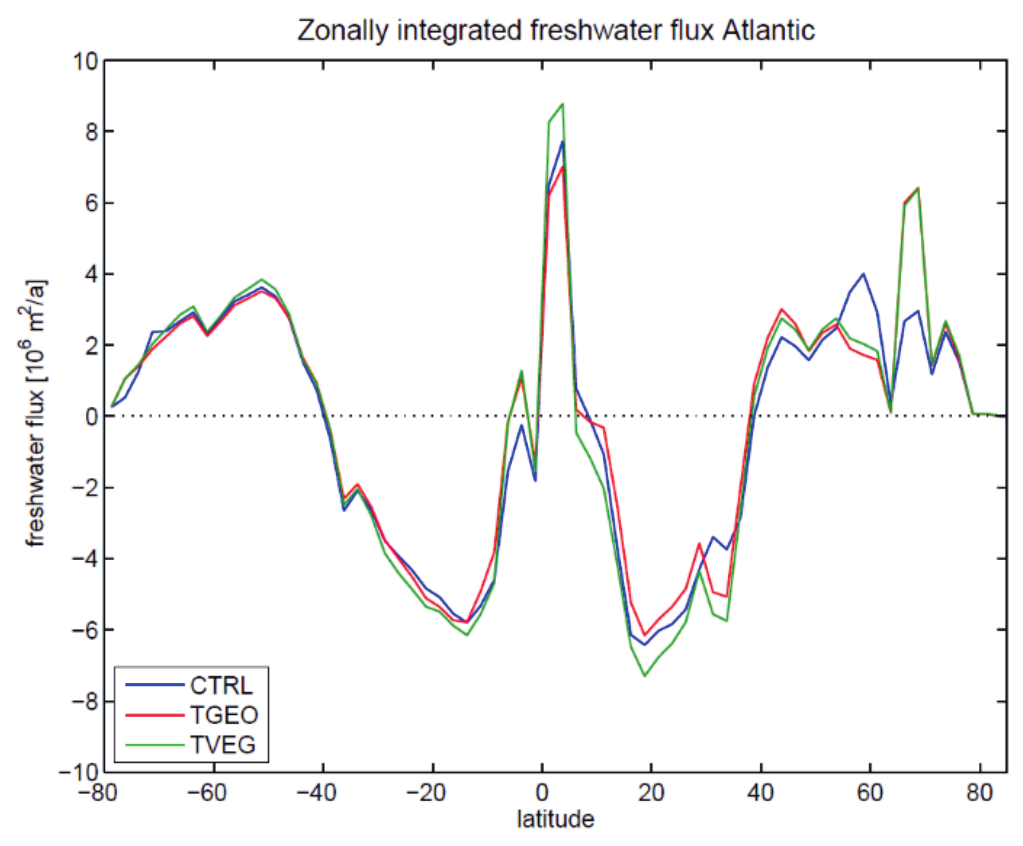
Figure 4. Annual mean net freshwater fluxes in the Atlantic Ocean for CTRL, TGEO, and TVEG. For the calculation of the net freshwater flux, the catchment areas in the ocean model have been taken into account (as in Lohmann, 2003, [63]). South of 35° S, the Atlantic Ocean is defined by the longitudes of the southern tips of South America and Africa,